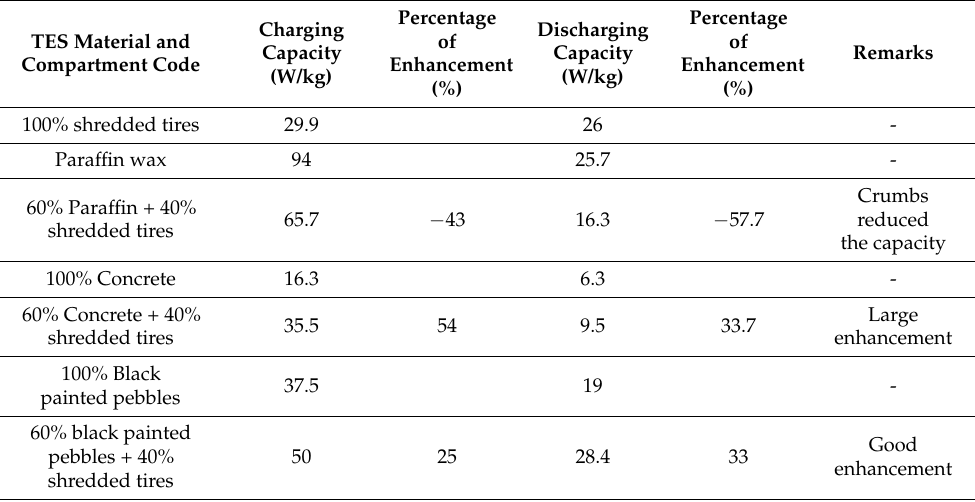
Figure 10. Comparison of the charging and discharging capacity of the seven tested TES materials. The contribution of the added tire crumbs to the tested base TES materials is summa- rized in Table 7. Adding tire crumbs to the paraffin wax has a negative effect, where the charging capacity is reduced by 42.9%, and the discharging capacity is reduced by 57.7%. In contrast, the concrete and the pebbles show enhanced storage capacity. Adding 40% vol of crumbs to the concrete increased the charging capacity by 54% and discharging capacity by 33.7%. The 40% vol added tire crumbs to the pebbles increased its charging capacity by 25% and the discharging capacity by 33%. Table 7. Charging and discharging capacities of the tested materials and the effect of adding tire crumbs on the base materials storage capacities.